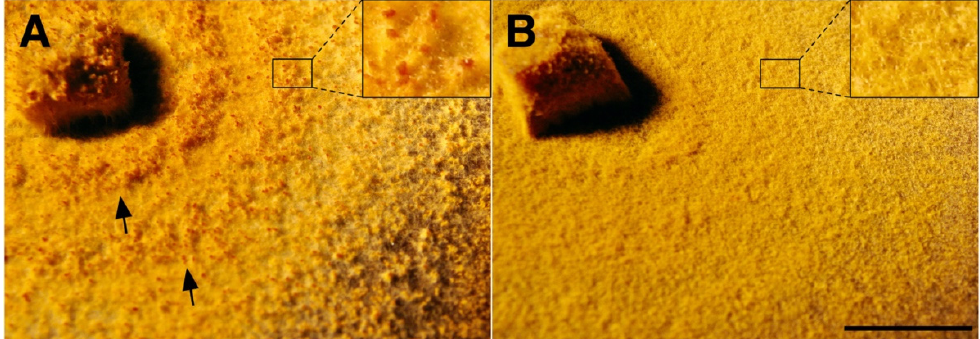
Figure 10. Morphology of isogenic strain M9290 of Cryphonectria carpinicola after cross-species infection with CnFGV1. ( A ) Mycelium of the virus-free isolate M9290 formed numerous dark- orange pycnidia, which developed in concentric rings due to light/dark growth conditions (arrows). ( B ) Mycelium of the isogenic CnFGV1-infected strain M9290-HII that lacks visible pycnidia. ( A , B ) In each upper right box, magnification of the mycelium surface with pycnidia in ( A ) and without pycnidia in ( B ). Scale bar = 1